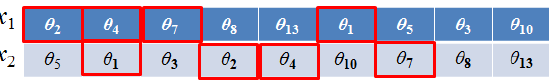
Figure 3. Feature similarity based on sliding windows, where α = 4. When K = 7, the number of overlapping models is 4. Then the similarity between x 1 and x 2 is 4